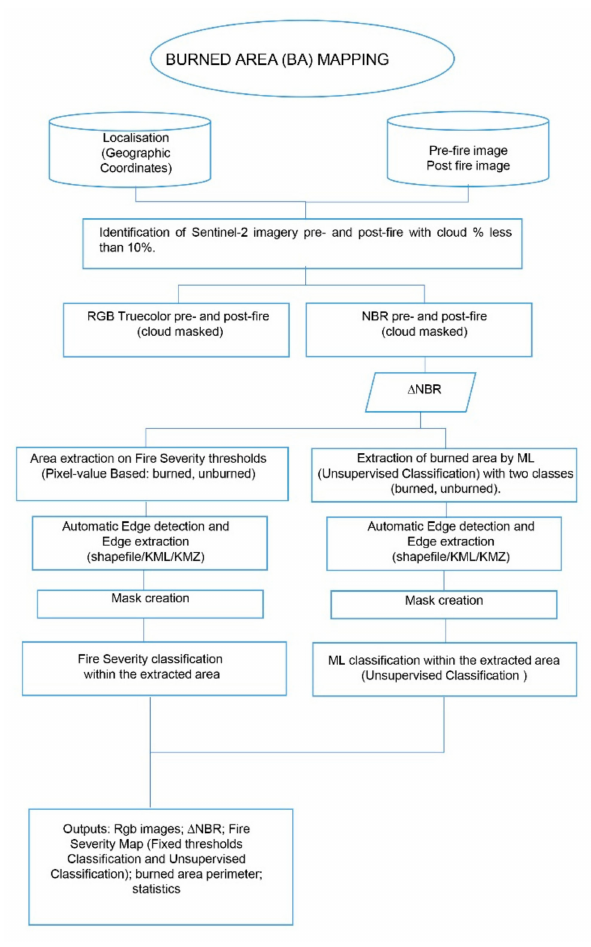
Figure 6. Flowchart for Burned Area (BA)